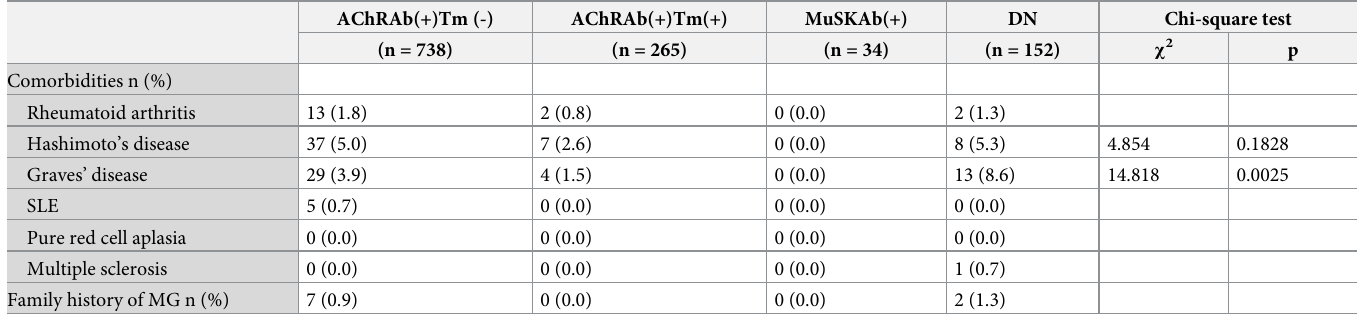
Table 6. Comorbidities and family history of